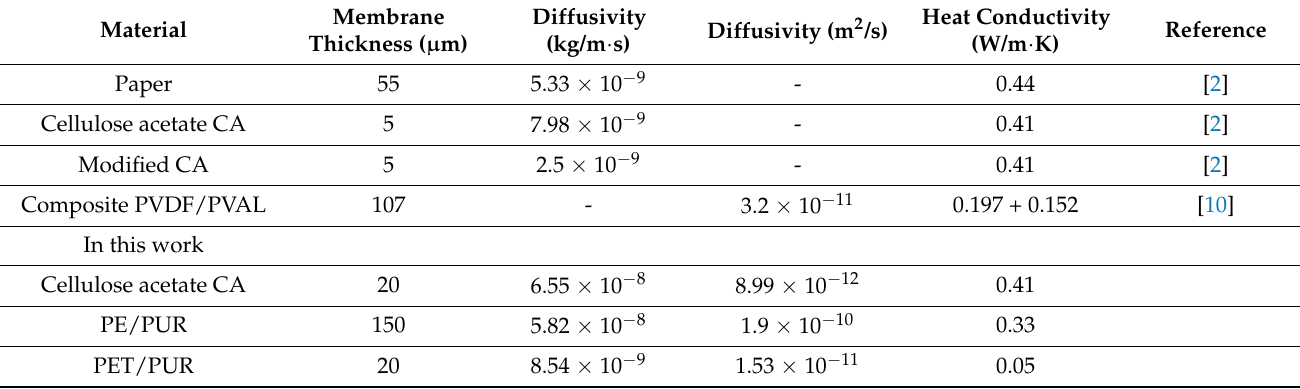
Table 3. Comparison of water vapor diffusivities in the